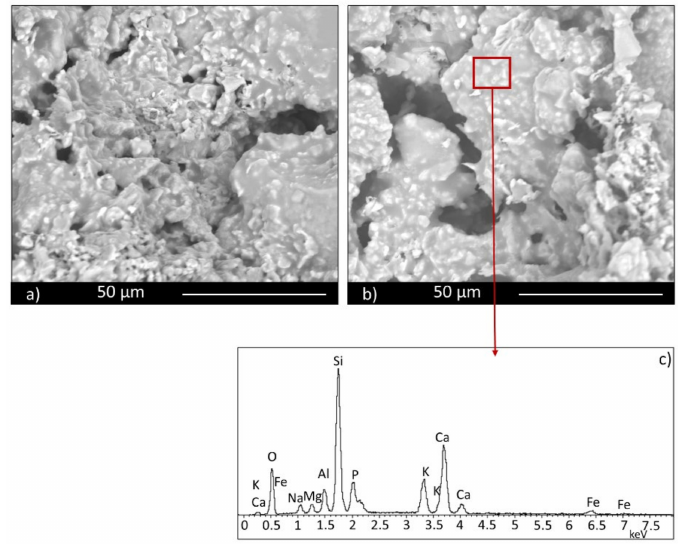
Figure 8. Scaffold (SS FG50) surface ( a ), section ( b ), and EDS analysis ( c